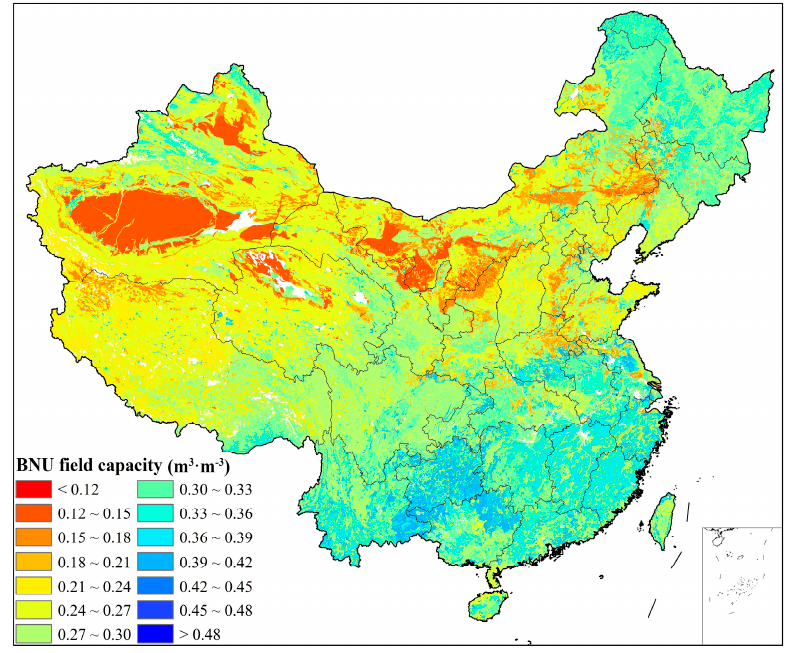
Figure 9. Distribution of BNU field capacity. Color bar is the same as that in Figure 5.